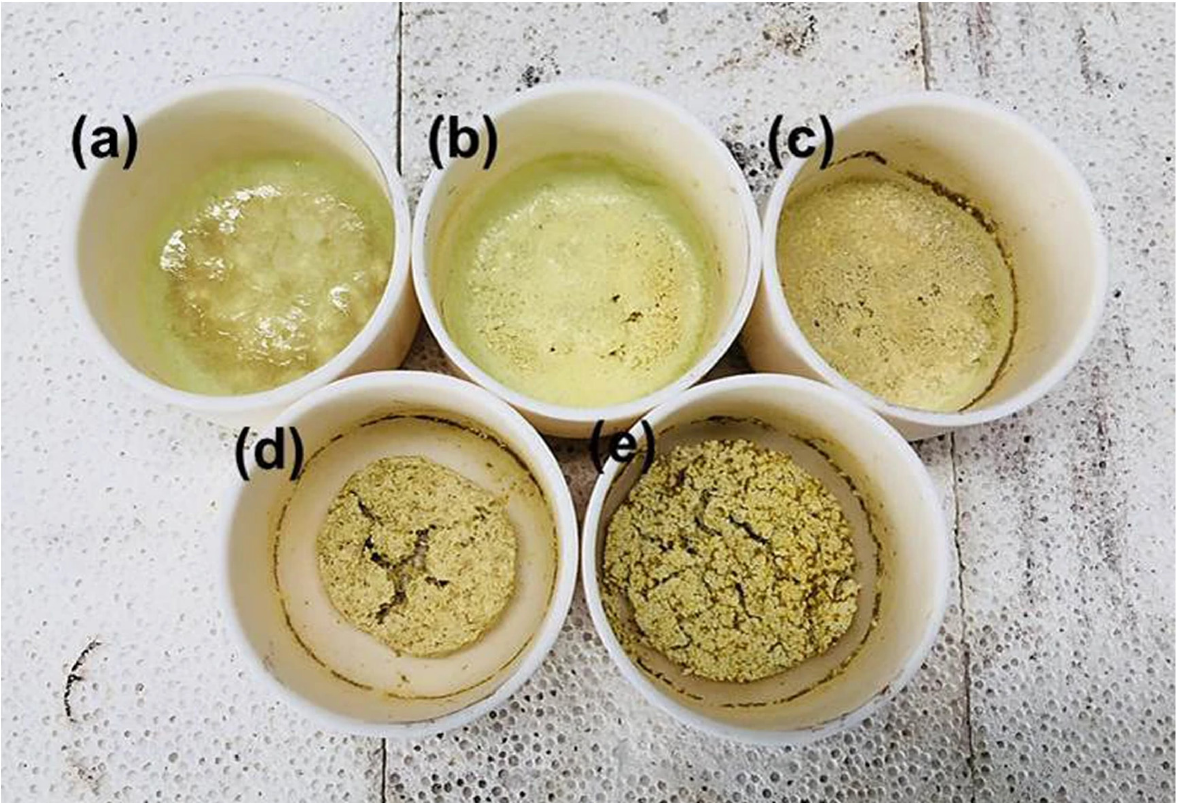
Figure 3. Actual appearance of samples after alkali fusion reactions for 20 min at 950 °C in various molar ratios (MO X /Na 2 O+MO X , M = Ti, Si, W): ( a ) 0.3, ( b ) 0.4, ( c ) 0.5, ( d ) 0.6, ( e ) 0.7. Reproduced with permission [48]. Copyright 2019, Springer Nature.